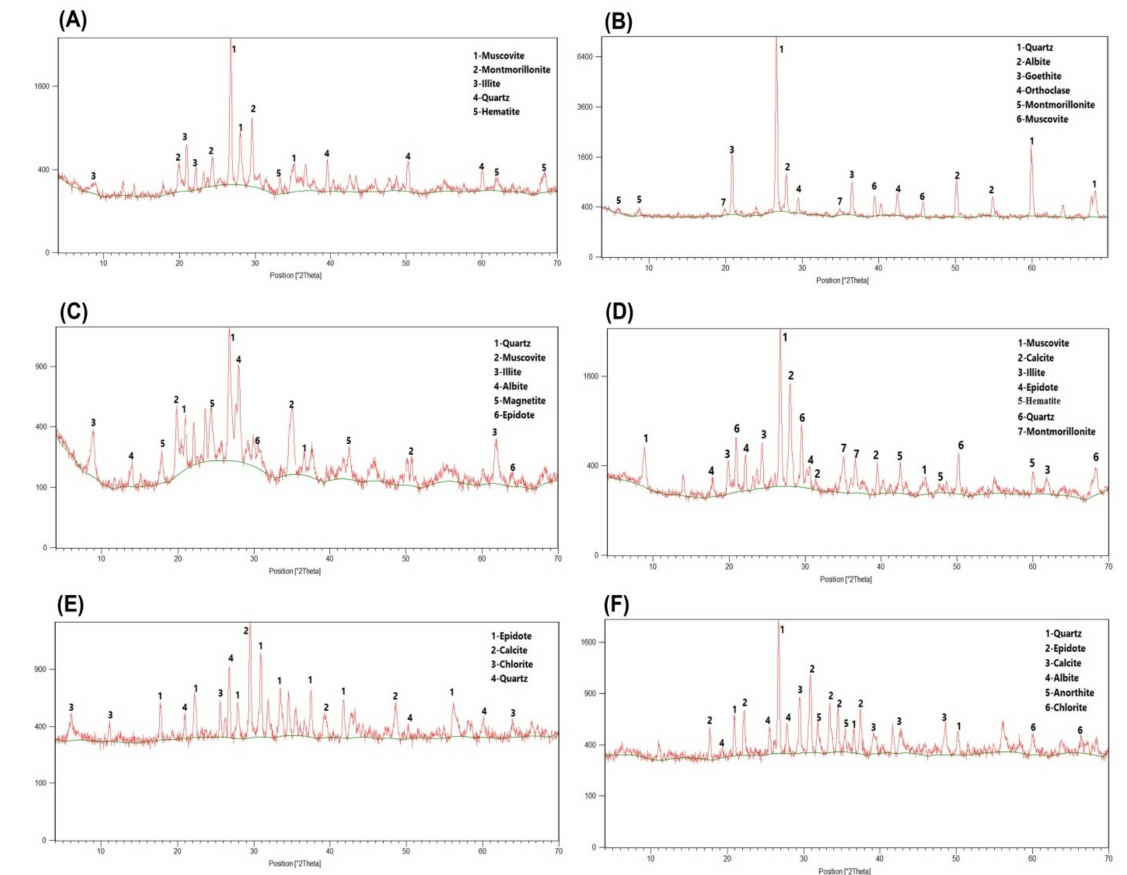
Figure 12. Results of XRD analysis shows minerals of representative samples collected from ( A ) and ( B ) advanced argillic and argillic zones; ( C , D ) phyllic zone; and ( E , F ) propylitic